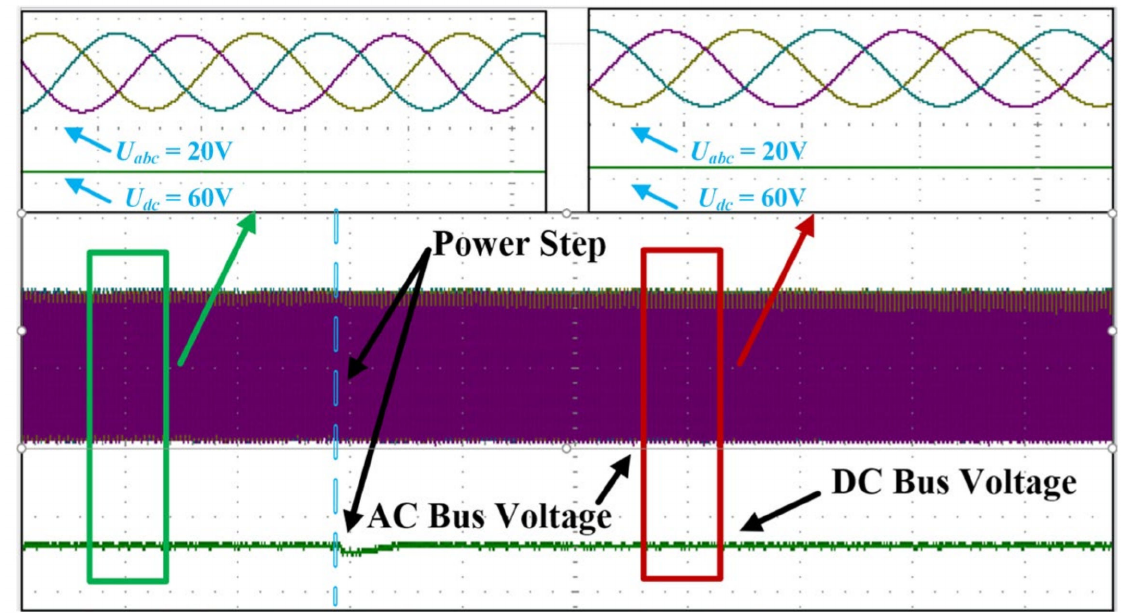
Figure 15. AC and DC bus voltage waveforms of microgrids when battery is in discharging mode (CPL power varied from 40 W to 80